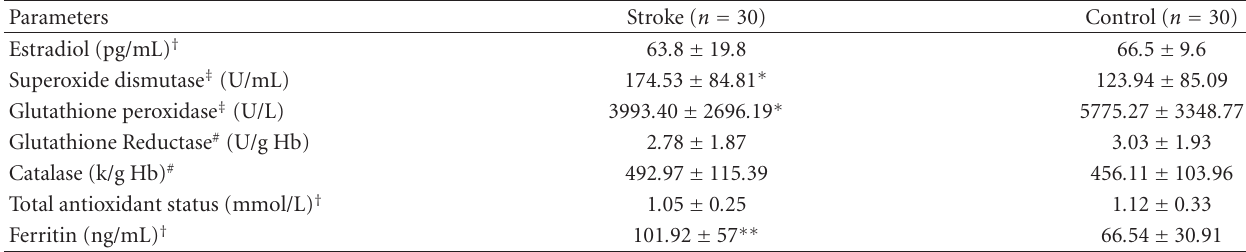
Table 1: The mean ± SD values of the estradiol, ferritin and total antioxidant status, superoxide dismutase and glutathione peroxidase, glutathione reductase and catalase of the stroke and control group.